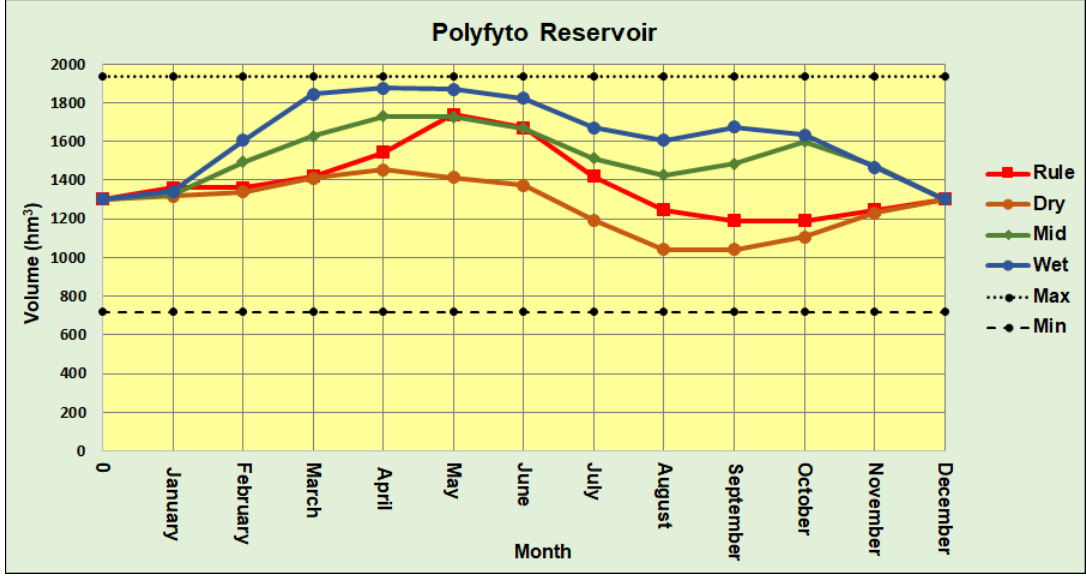
Figure 8. The optimal operation policies for the current state of water resources demand, ignoring the institutional operating rule curves for Polyfyto reservoir. Energies 2020 , 12 , x FOR PEER REVIEW 15 of 22